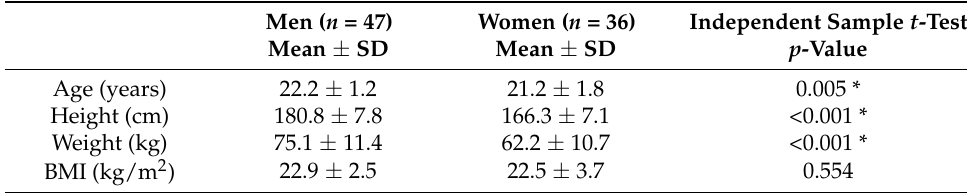
Table 1. Descriptive statistics of study sample characteristics (mean ± standard deviation) for male and female